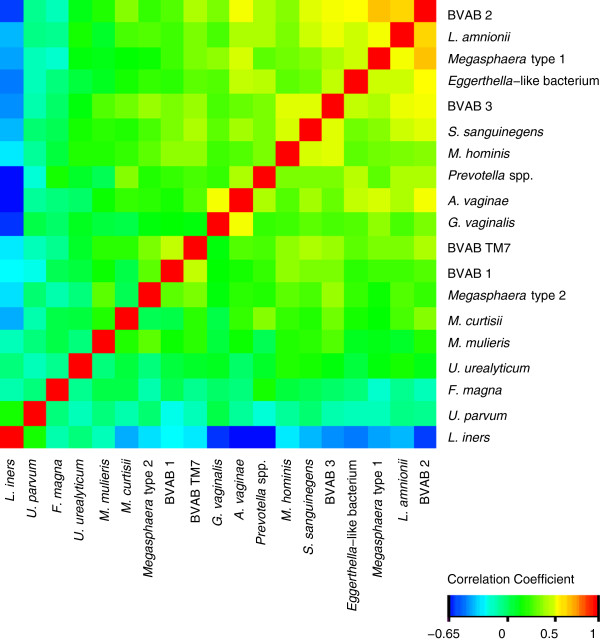
Co-occurrence of bacterial species. Hierarchically clustered Spearman correlation coefficients between bacterial species. Correlation values range from -0.65 to 1. Diagonal elements have a correlation of 1. Several bacteria associated with BV occur together. A tabulation of the coefficients is available in (Additional file 2: Table S2).